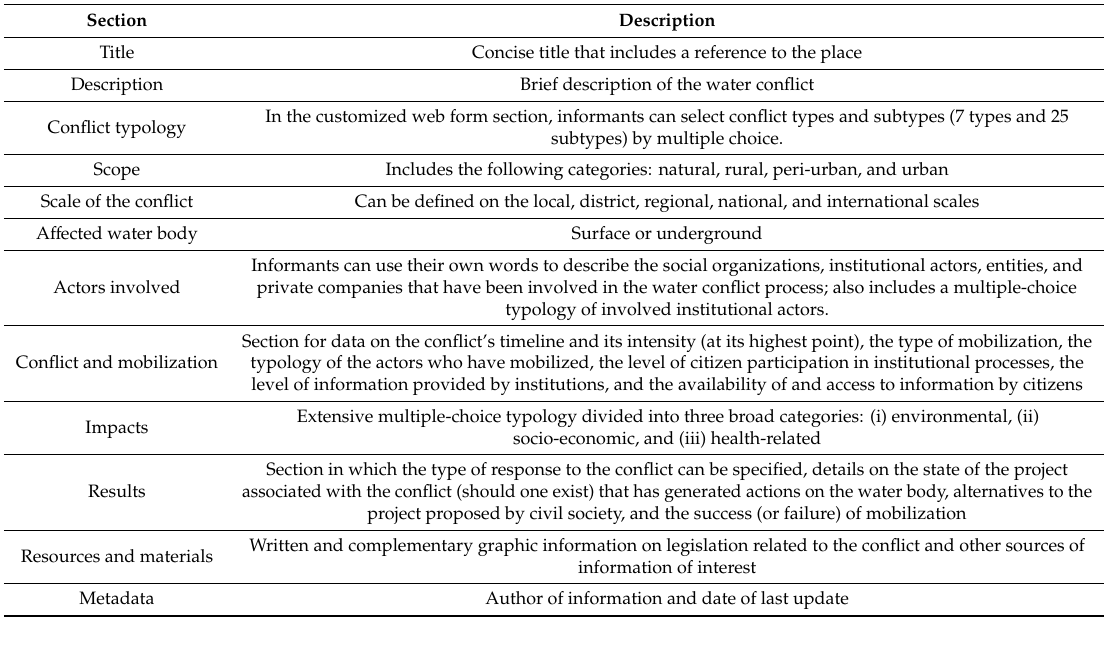
Table 2. Customized report database content.